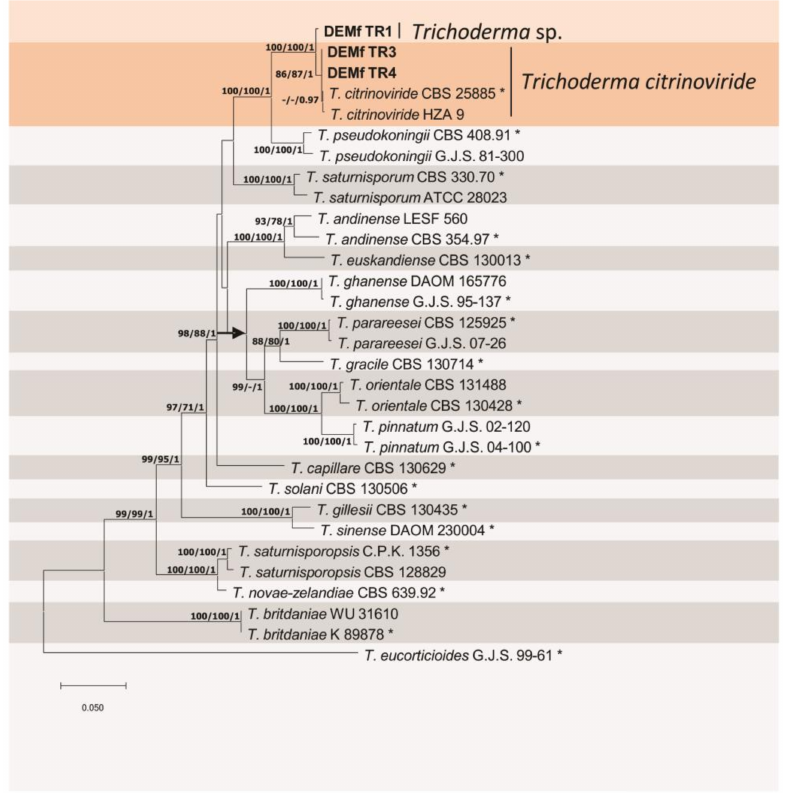
Figure 1. Phylogenetic tree generated from maximum likelihood analysis (ML) based on concatenated alignments of ITS, tef 1- α and RPB2 sequence data showing the position of Trichoderma citrinoviride in relation to its closely related species belonging to the Longibranchiatum clade. ML and maximum parsimony (MP) bootstrap support values greater than 70% and Bayesian posterior probability values (PP) greater than 0.95 are indicated at the tree nodes (ML/MP/PP). The type strains are marked with an asterisk and isolates sequenced in this study are shown in bold. T. eucorticioides G.J.S. 99-61 (clade Hypocreanum) is included as an outgroup. Scale bar indicates expected number of substitutions per